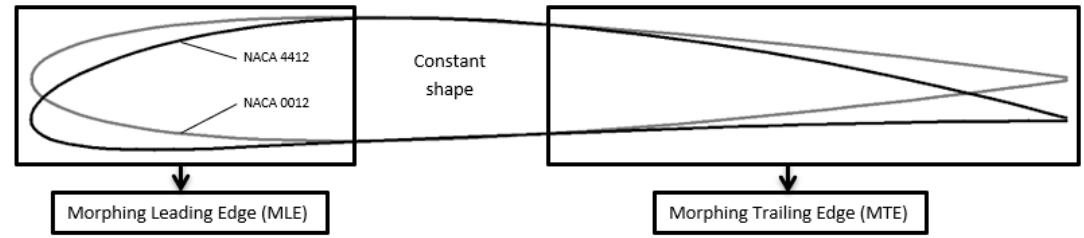
Figure 1. NACA0012 and NACA4412 airfoils superimposed.